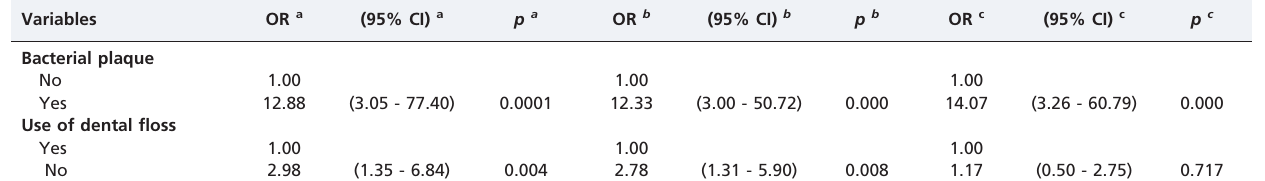
Table 4 - Multivariate analysis of the association between oral health variables and periodontitis in pregnant women from Recife, Brazil,